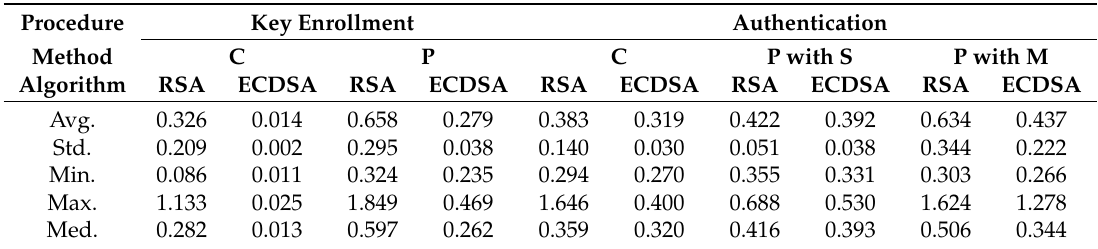
Table 1. Times (seconds) for key enrollment and authentication (C: Conventional System, P: Proposed System, S: Salt Server, M: Mobile